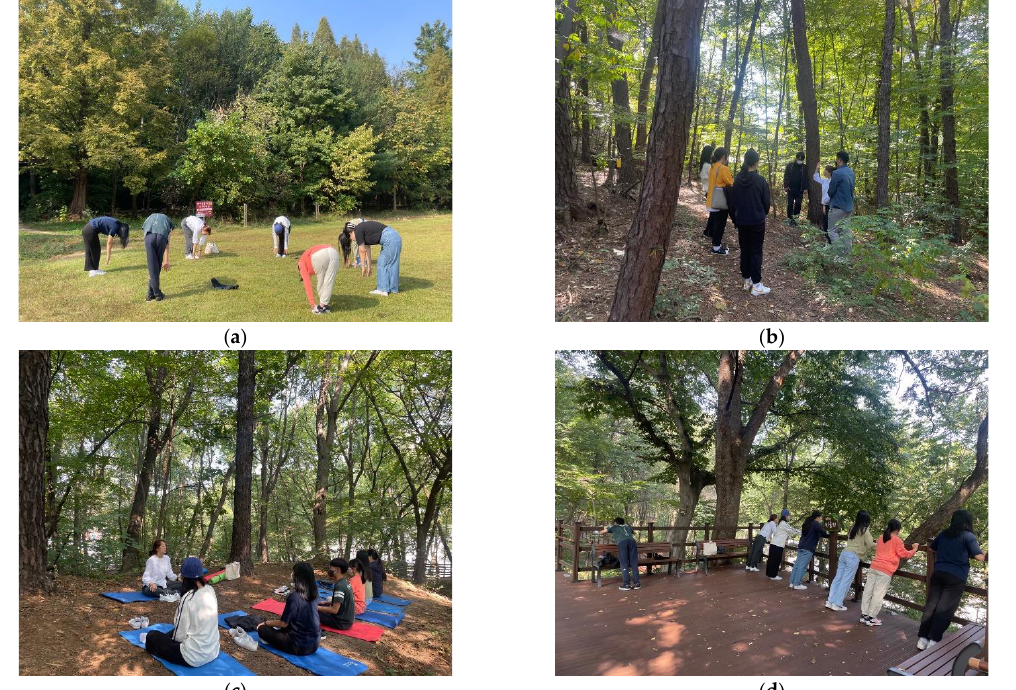
Figure 4. The guided forest-healing program. ( a ) stretching; ( b ) diaphragmatic respiration; ( c ) meditation; ( d ) exercise.